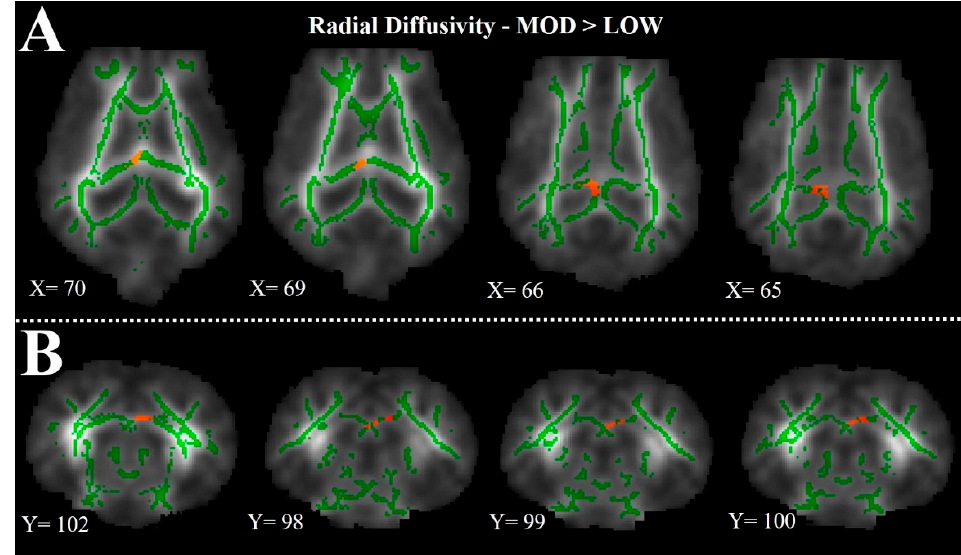
Figure 3. Tract-based spatial statistics (TBSS) illustrating differences in radial diffusivity (RD) between LOW and MOD dietary sialyllactose (SL) pigs. Pigs provided the MOD dietary SL treatment exhibited higher ( p < 0.05) rates of radial diffusivity in the left hemisphere corpus callosum, when compared with LOW dietary SL pigs. The images generated from TBSS are and average of all LOW and MOD dietary SL pigs, green lines indicate regions in which all pigs exhibited white matter voxels. Representative slices were chosen to highlight areas in which RD values in MOD dietary SL pigs were significantly ( p < 0.05) different compared with LOW dietary SL pigs. ( A ) Axial slices, with varying X-coordinates and static Y = 120 and Z = 76 coordinates, determined using University of Illinois Pig Brain Atlas [14]; ( B ) Coronal slices, with varying Y-coordinates and static X = 73 and Z = 87 coordinates, determined using the University of Illinois Pig Brain Atlas. Dark red and light red colors indicate degree of statistical differences from p = 0.05 to p < 0.01, respectively. For a more comprehensive image set of TBSS images the reader is referred to Supplemental Figure 1.